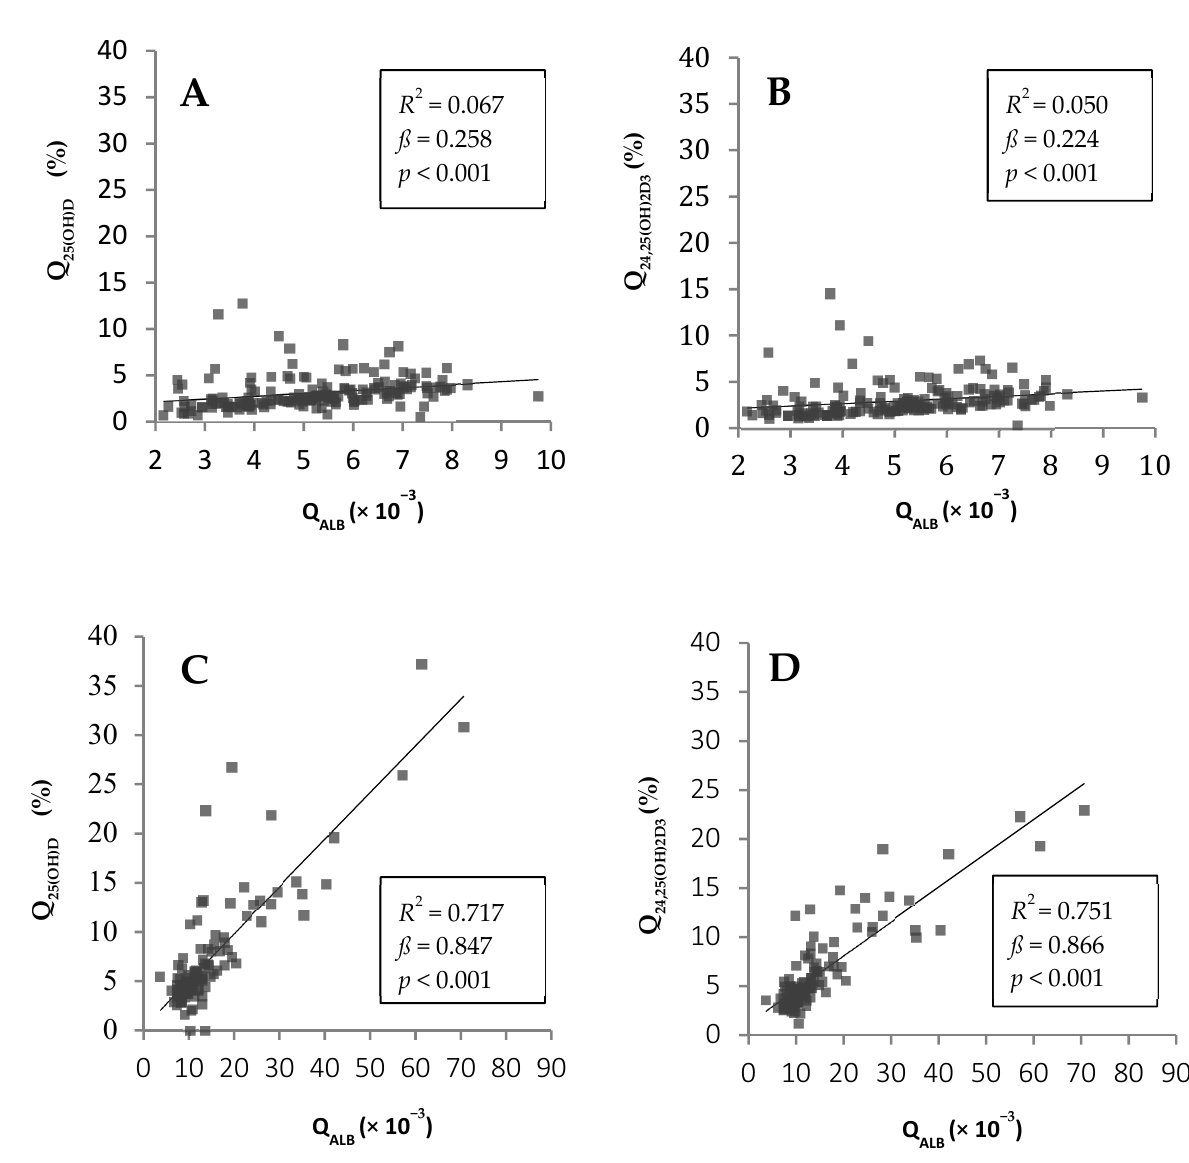
Figure 2. Univariate regression models between blood-CSF barrier (BCB) function (Q ALB , × 10 − 3 ) and the cerebrospinal fluid (CSF)/serum ratios of 25(OH)D (Q 25(OH)D ) and 24,25(OH) 2 D 3 (Q 24,25(OH)2D3 ) in patients without ( n = 175) ( A – B ) and with ( n = 117) ( C – D ) BCB dysfunction.